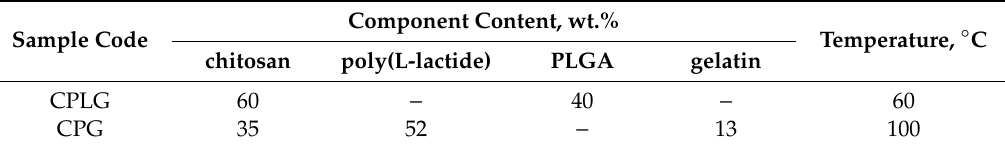
Table 1. Copolymer sample codes and synthesis